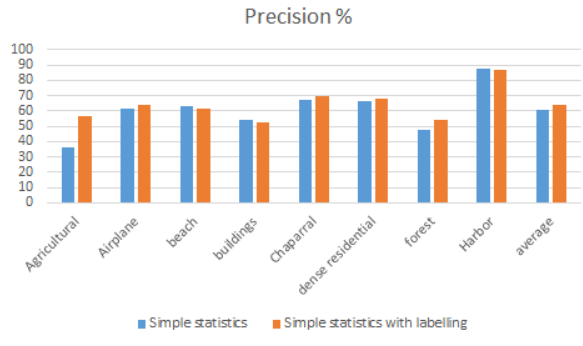
Figure 9. Average precision using simple statistics with an without labelling for each category.